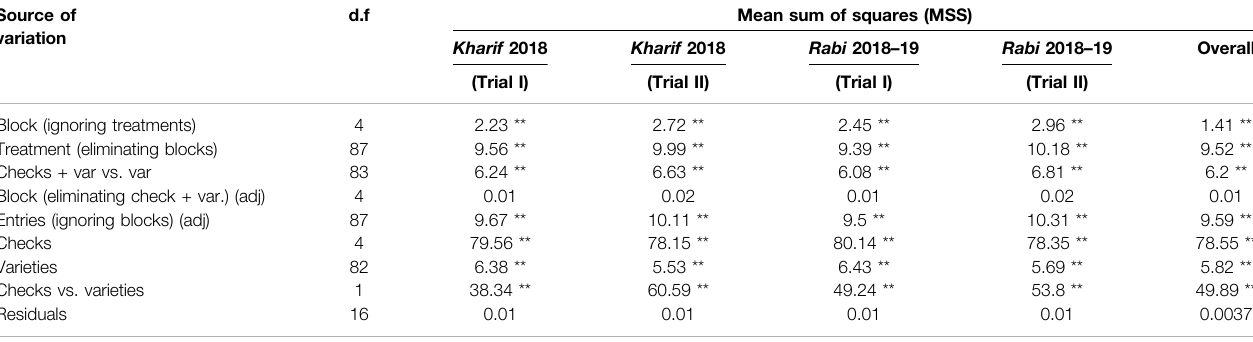
Block (ignoring treatments)